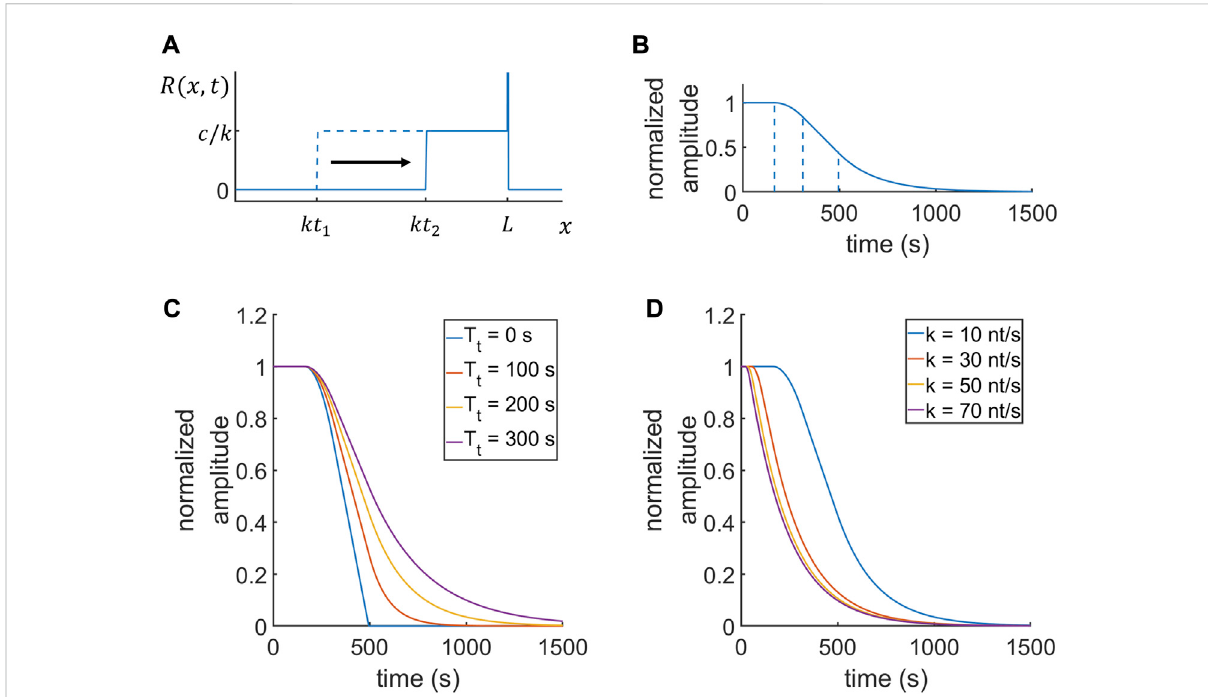
FIGURE 2 Model functional behaviors of the time-resolved transcription analysis. (A) The change in Pol II density distribution from t 1 to t 2 . The transcriptioninitiationinhibitorwasaddedat t (cid:2) 0. (B) Themodelfunctionofthetranscriptionintensityovertimeafteraddingtheinhibitor. (C,D) The modelfunctioncalculatedfordifferentterminationtimes (C) andelongationrates (D) .For (C) ,theelongationratewas fi xedat k (cid:2) 10nt/s,andfor (D) , the termination time was T t (cid:2) 200